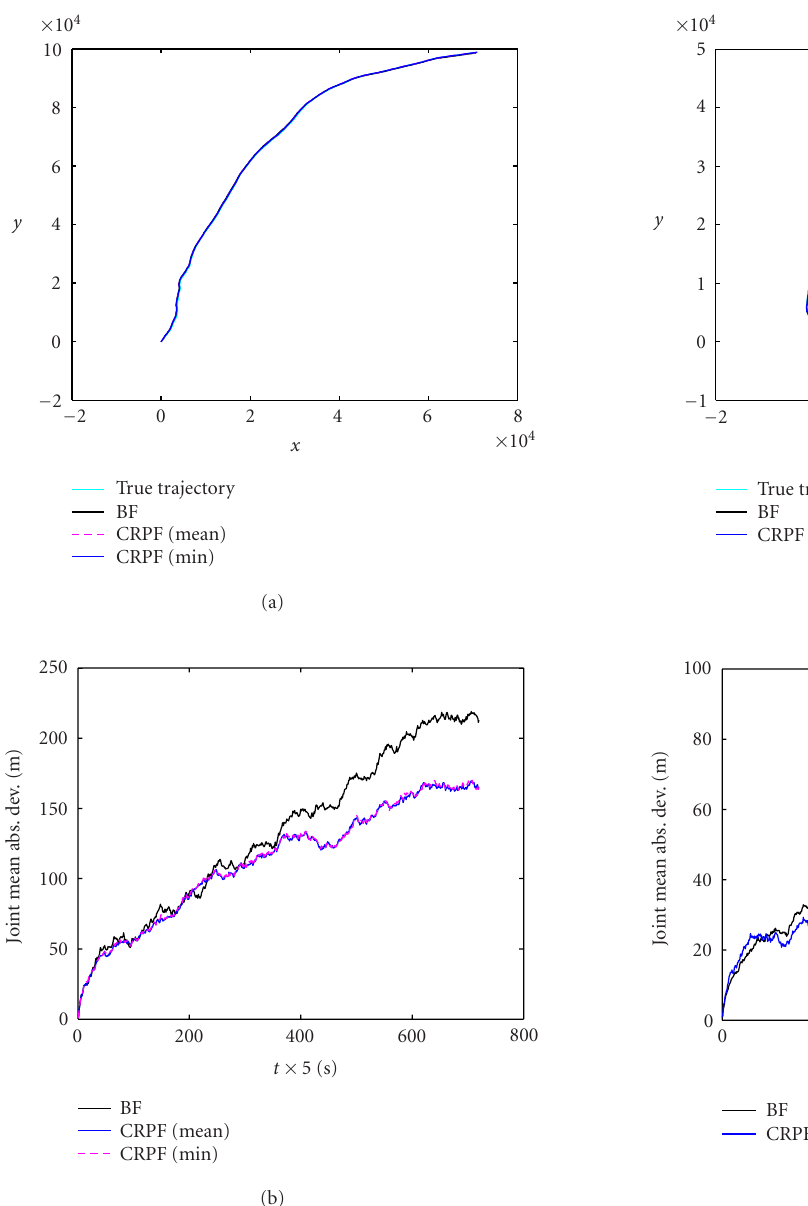
Figure 8: Di ff erent estimation criteria. T s = 5 seconds. (a) Trajec- tory. (b) Mean absolute deviation.